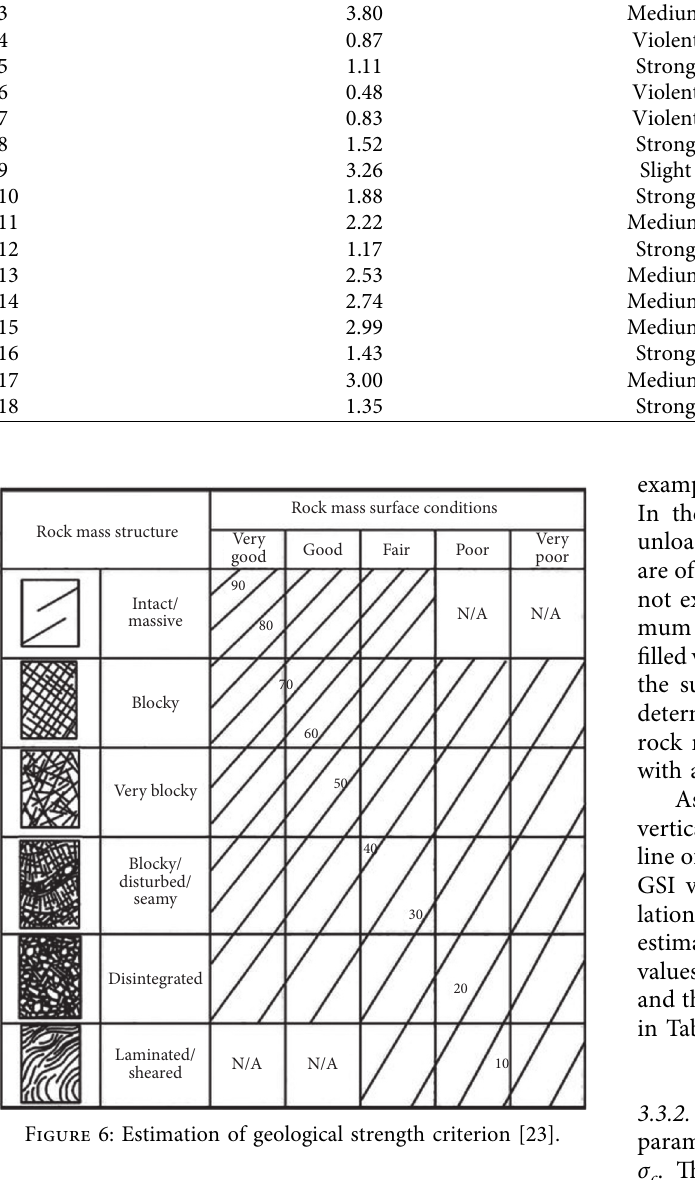
rock mass structure in which a plurality of sets of discon- tinuous surfaces are mutually cut to form an angular rock mass, and undergoes a fold activity, a layer, or a flank plane continuous; Disintegrated means a severely fractured rock mass, which contains a mixture of angular and circular rock blocks; Laminated/Sheared means the lack of a massive rock mass structure due to the weak schistosity or the close spacing of the shear planes. The corresponding range of values is from 100 to 0 in order of high to low, and the higher the value, the better the integrity of the rock mass.